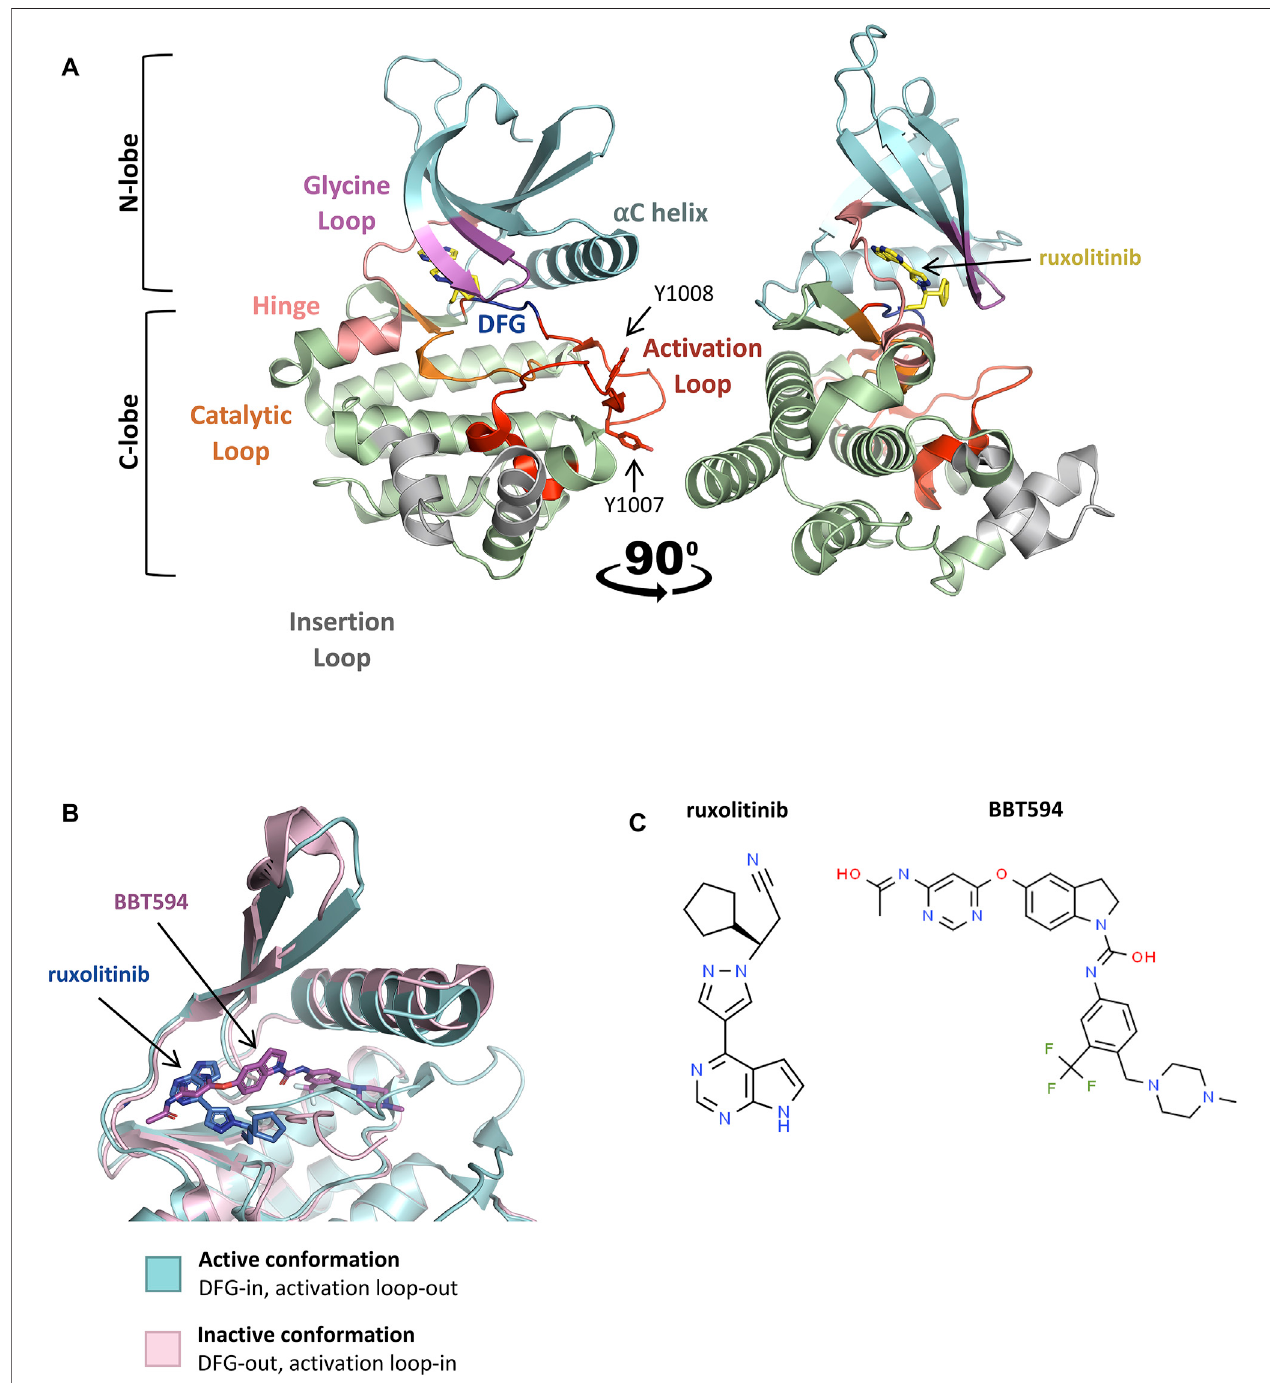
FIGURE3| ActiveandinactiveconformationsofJAK2. (A) Co-crystalstructureofthetype-IJAKinhibitor,ruxolitinib,boundtotheJAK2kinasedomainintheactive conformation (PDB: 6VGL). Ruxolitinib (yellow) is presented in ball-and-stick representation with nitrogen atoms in blue. The JAK2 kinase domain is presented in ribbon representationwithaminoacidsidechainsshownforessentialphosphotyrosineresidues, JAK2 p.Y1007andp.Y1008.TheN-terminallobe(residues840 – 931),shown in cyan, comprises a 5-stranded antiparallel β -sheet and one α -helix ( α C). The C-terminal lobe (residues 932 – 1,132), shown in green, comprises 8 α -helices, 3 3/ 10 helices, and 3 pairs of antiparallel β -strands. The glycine loop is colored in pink, the hinge region between the 2 lobes in peach, the catalytic loop in orange, the activation loop in red, DFG-motif in blue, and the insertion loop in grey. (B) Superimposition of the active (blue) and inactive (pink) conformations of the JAK2 kinase domain ATP-binding site within co-crystal structures bound to JAK inhibitors. Ruxolitinib (dark blue) and the type-II JAK inhibitor, BBT594 (dark pink), are bound to the active (PDB: 6VGL) and inactive (PDB: 3UGC) conformations respectively. JAK inhibitors are presented in ball-and-stick representations with oxygen atoms in red and nitrogen atoms in blue. The JAK2 activation loop is disordered in the inactive conformation. Structures were visualized with PyMOL 2.0 (Schrödinger, LCC). (C) 2D chemical structures of ruxolitinib (ChemSpider, CSID: 25027389) and BBT594 (ChemSpider, CSID: 34980928)